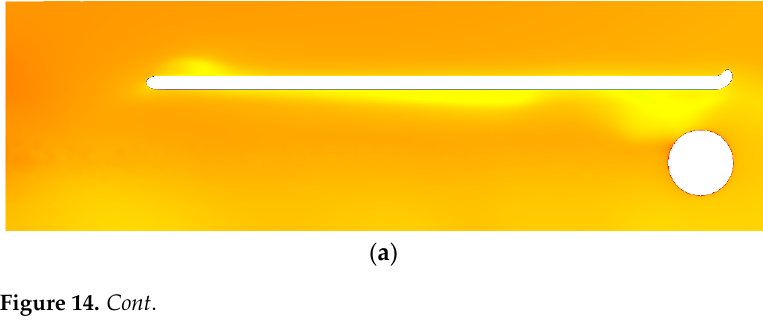
Figure 13. The variation in the shell (water) temperature against the inlet mass flow rate.